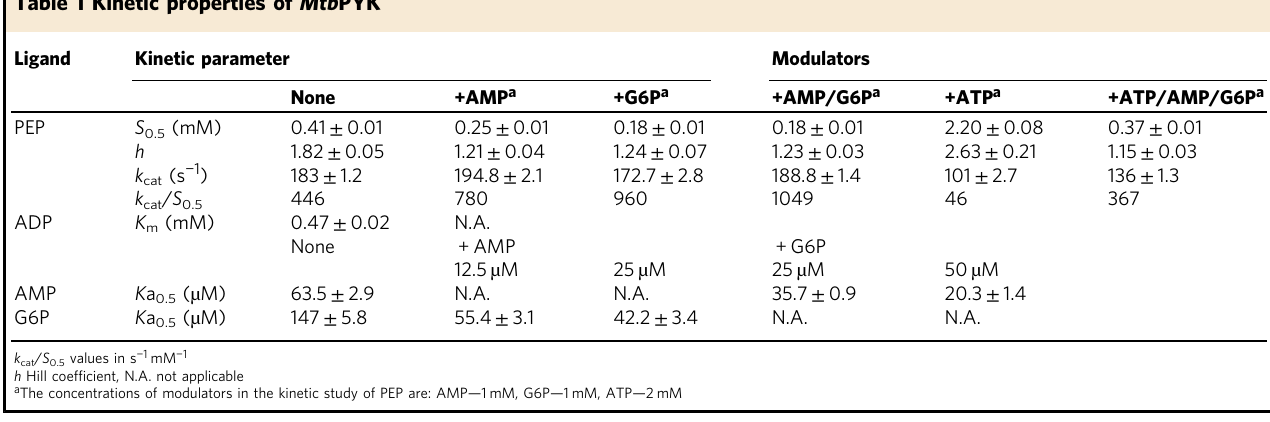
The concentrations of modulators in the kinetic study of PEP are: AMP — 1mM, G6P — 1mM, ATP —